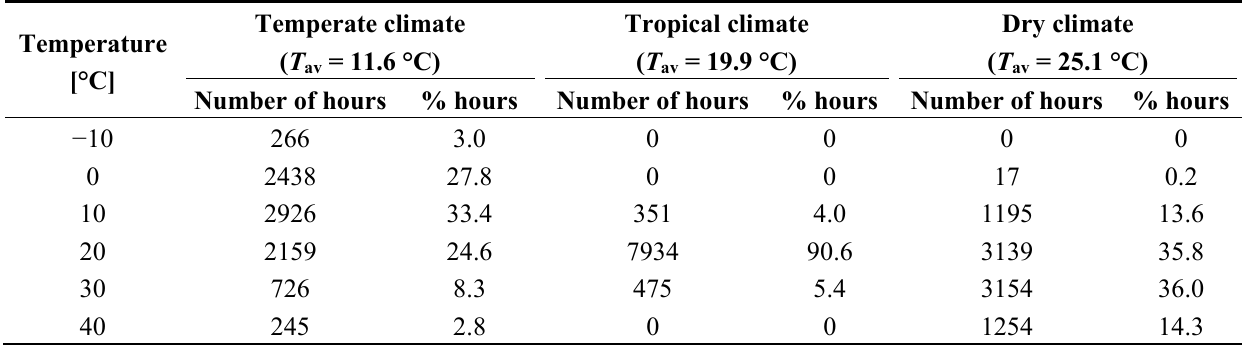
Table 4. Ambient temperature distribution of three climates during generic year.